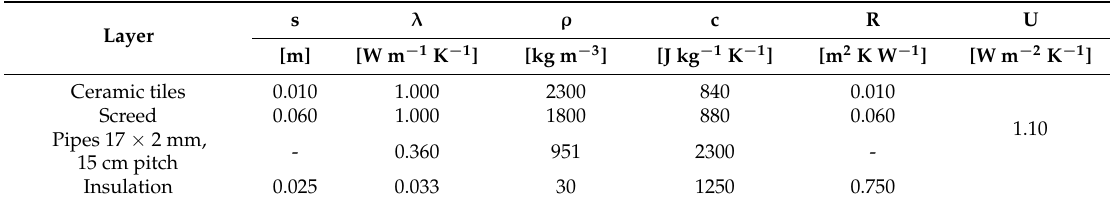
Table A5. Stratigraphy and thermal properties of the radiant floor with wet screed (FW).